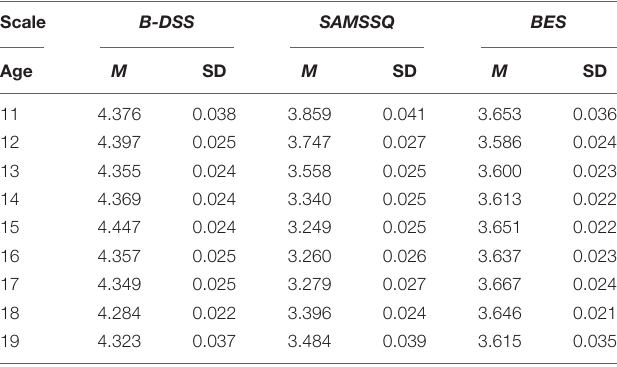
TABLE 3 | Descriptive analysis of age and the scores of the three kinds of abilities.